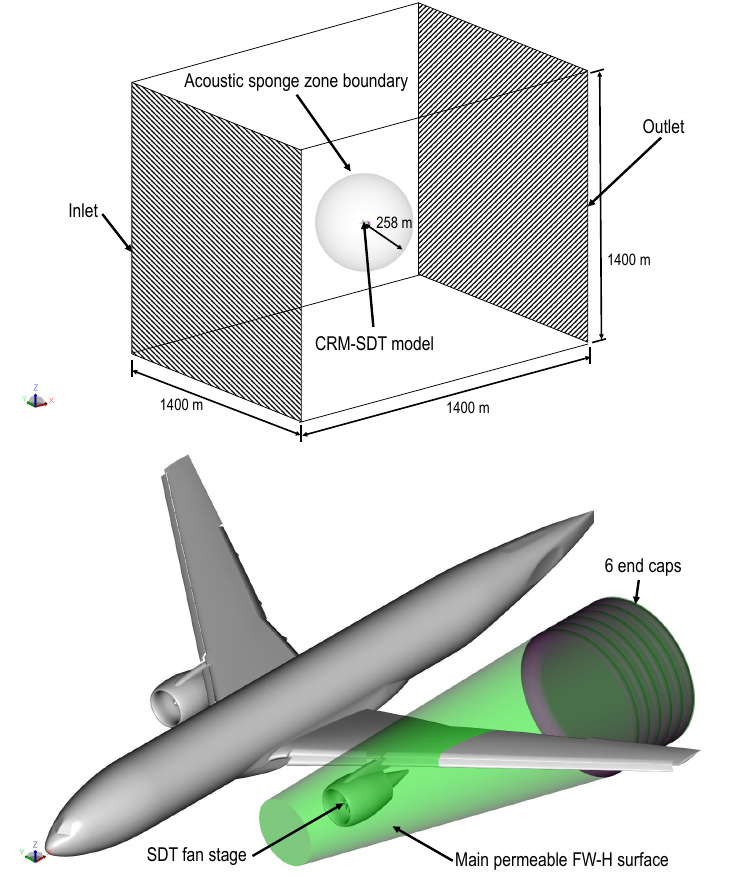
Figure 3. ( Top ) The simulation domain enclosing the CRM/SDT model. ( Bottom ) The configuration of permeable FW-H surface for noise analyses.